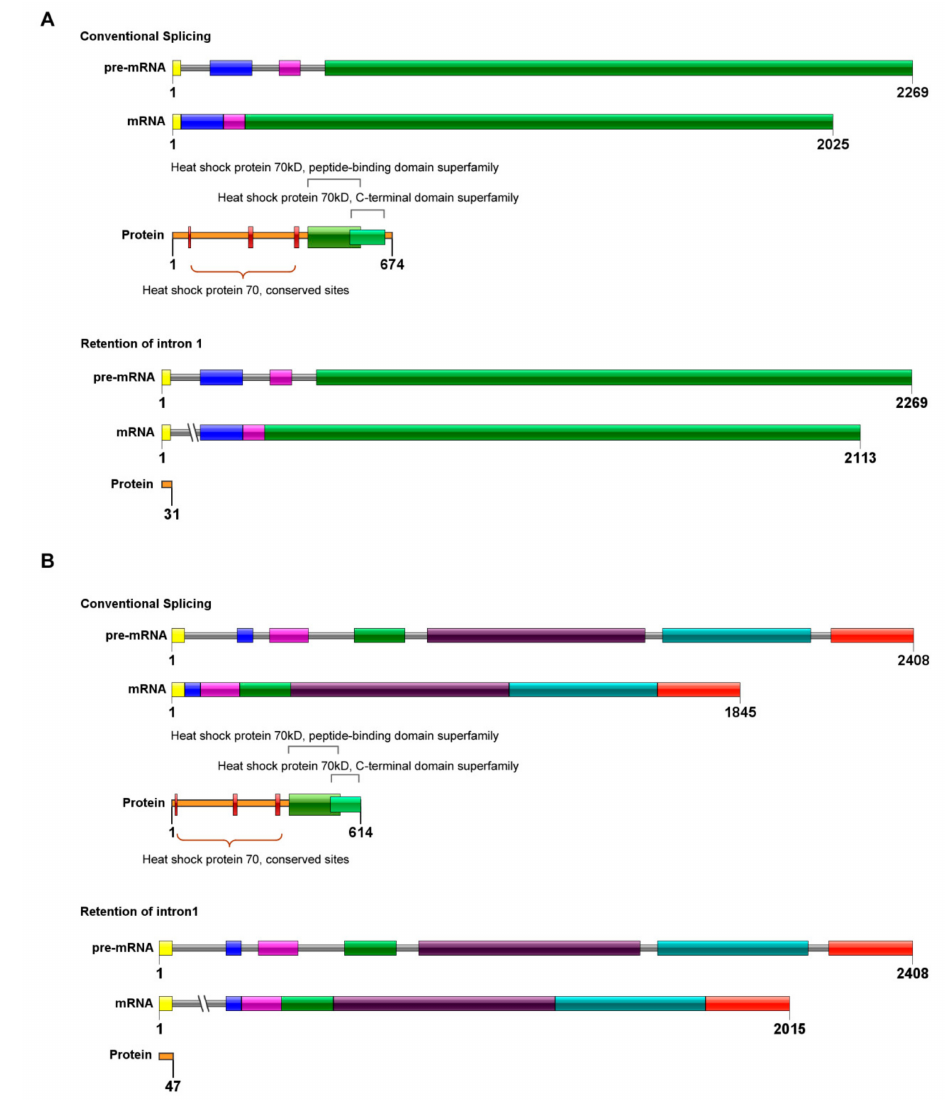
Figure 1. Schematic representation of Intron1 retention in Hsp70 family members in Trichophyton rubrum , showing DNA organization, mRNA, and proteins resulting from conventional splicing and alternative splicing promoted by Intron1 retention. Exons are shown as colored boxes; introns are shown as solid lines. Premature stop codons are indicated by cut lines. Conserved sites and domains are indicated in the structure of the proteins. ( A ) hsp7-like gene. ( B ) hsp75-like